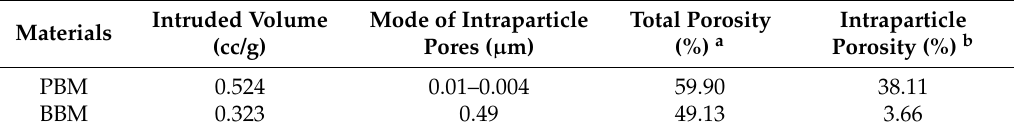
Table 1. Mercury-intruded volume, mode (most frequent diameter) of intraparticle pores, total porosity, and intraparticle porosity of commercial samples.